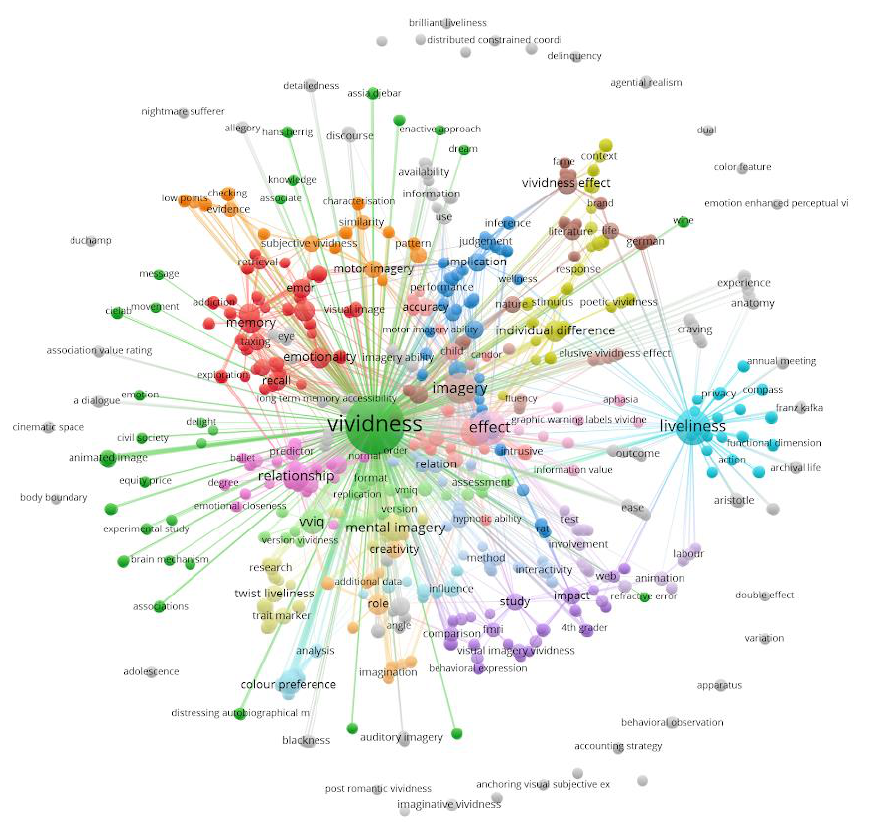
Figure 1. Network of words associated with ‘vividness’ or ‘liveliness’ in the titles of research articles. The network exposes how currently ‘vividness’ and ‘liveliness’ are potentially regarded as two distinct concepts or are researched independently by different disciplines. Figure taken from [1].